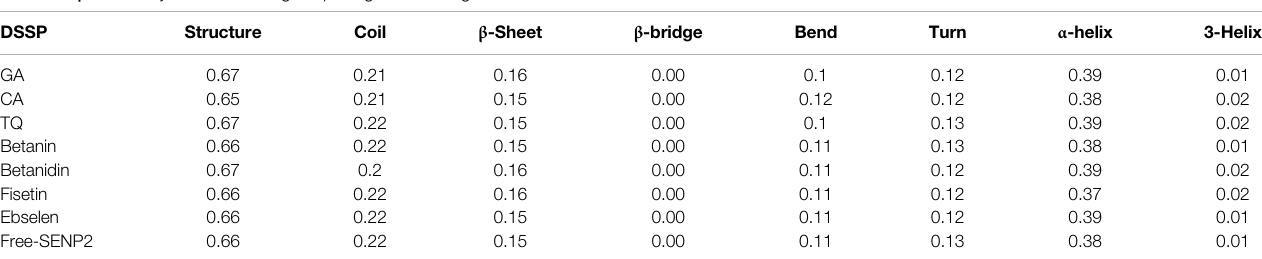
TABLE 5 | Secondary structure changes upon ligands binding.